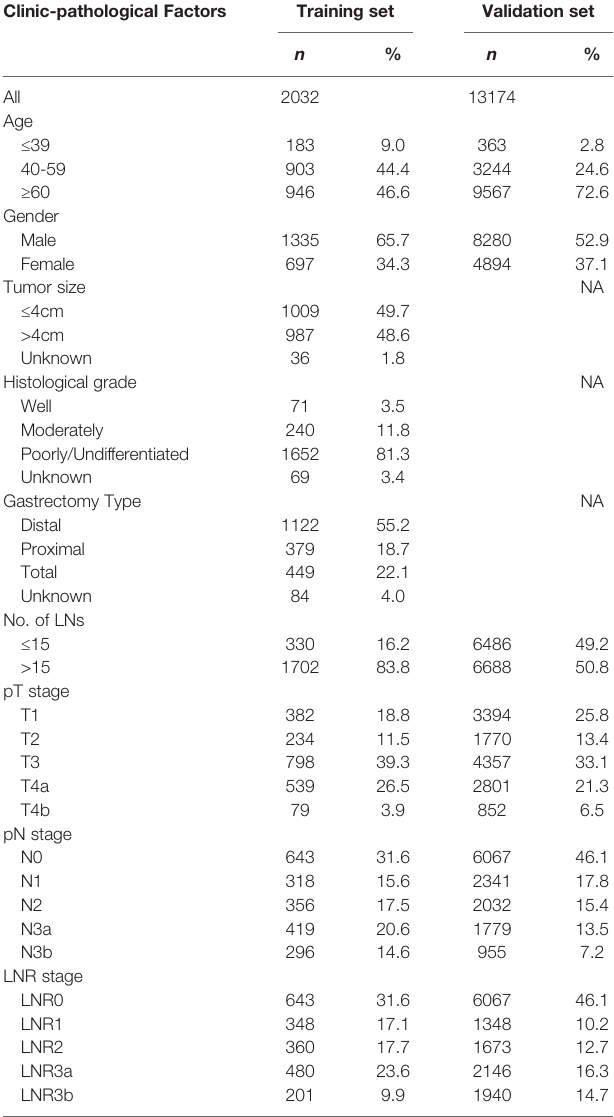
TABLE 2 | Clinic-pathological Factors of training set and validation